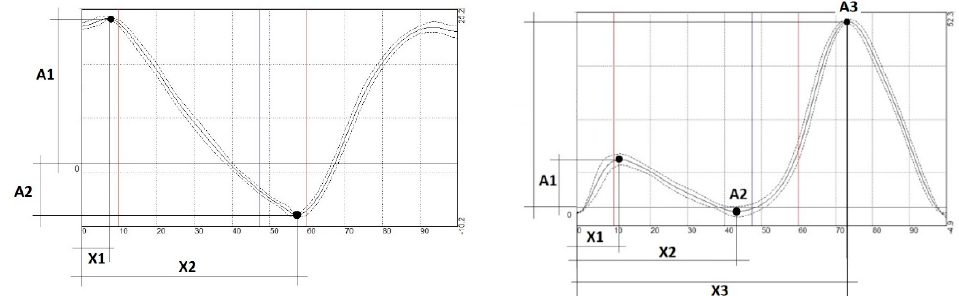
Figure 2. Measured amplitudes ( А ) and phases ( Х ) in the hip (left graph) and knee (right graph) goniograms.